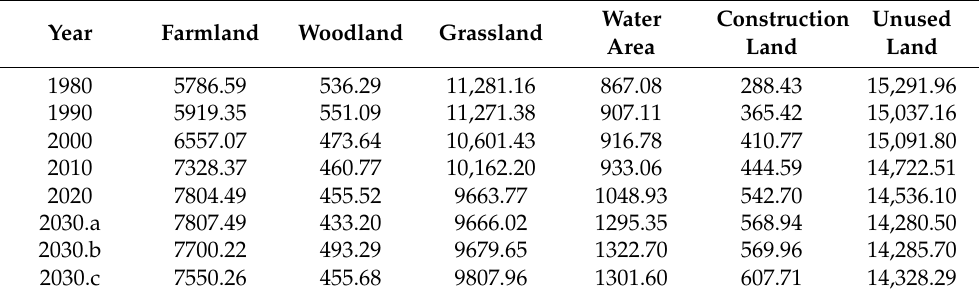
Figure 5. Changes in LULC types in the study area from 1980 to 2030.(Note: a, b, and c indicate ND, EPD, and EED scenarios, respectively). Table 2. Areas of LULC types in the Manas River Basin from 1980 to 2020, and predictions for 2030 under different scenarios (km 2